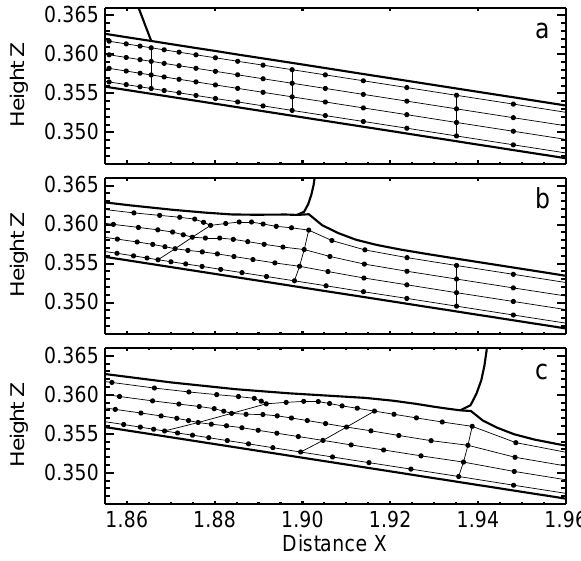
Fig. 12. Experiment C: Moderately stiff and moderately non-linear till ( m =3 , B =0 . 79 ): Sediment layers which were originally parallel to the bed (a) are deformed and form a wave to keep the sediment bulge in position (b–c). The snapshots were taken at dimensionless times T equal to 0 (a), 8 (b) and 14 (c) . Three vertical straight lines in (a) are followed throughout (b–c). Fig. 11. Experiment C: Moderately stiff and moderately non-linear till ( m =3 , B =0 . 79 ): (a) glacier surfaces are shown at time intervals of approximately two dimensionless time units. Selected front positions marked c, d and e are shown in more detail in subfigures (c–e). (b) shows the maximum height H b of the sediment bulge with its horizontal position. Note that the bulge is significantly smaller than in Fig. 4. (c–e) snapshots of the front showing the surface, four selected internal layers and the sediment surface at dimensionless times T equal to 0 (c) , 8 (d) and 14 (e) . The dots indicate material particles that can be followed throughout the three pictures. The connecting lines illustrate how material layers (fine solid and dashed lines) with initial shape as in (c) become deformed with time. The arrow marks the initial position of the glacier front. 37